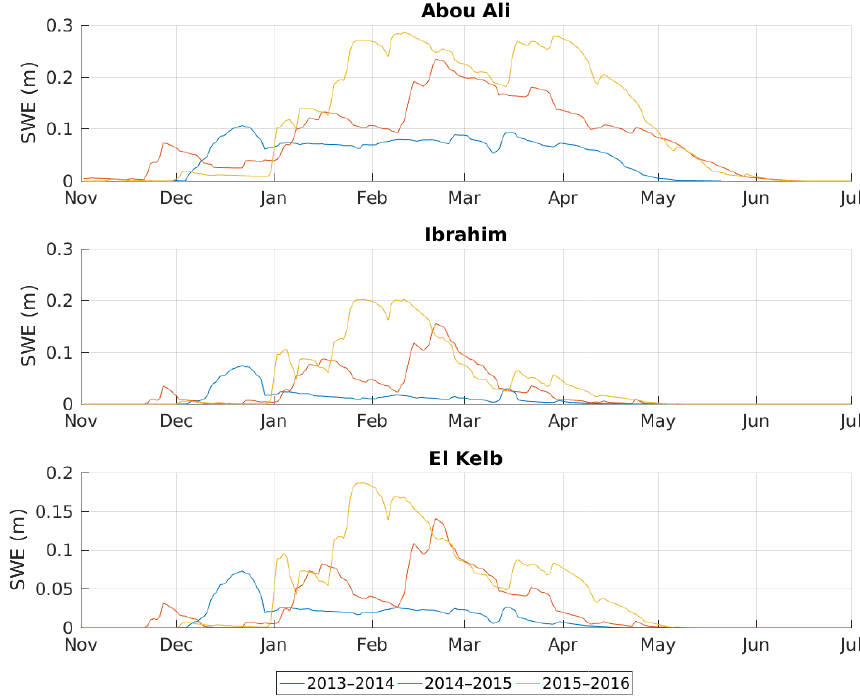
Figure 9. Temporal evolution of the simulated SWE above 1200ma.s.l., based on the Pflug et al. (2019) model